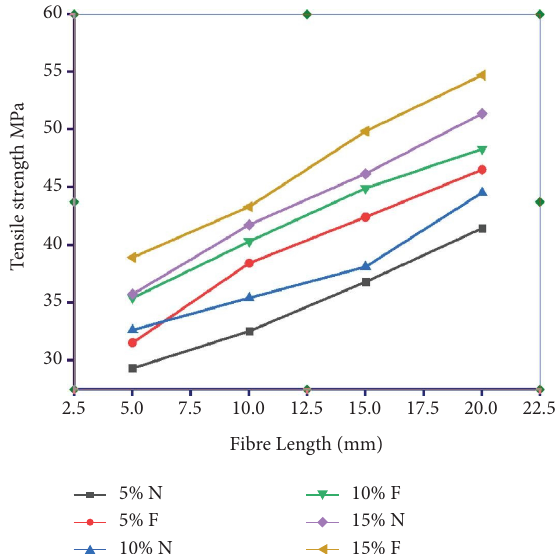
Figure 4: Flexural strength variation for diferent fbre wt.% and length (N-neat (without fller) and F (with fller)).